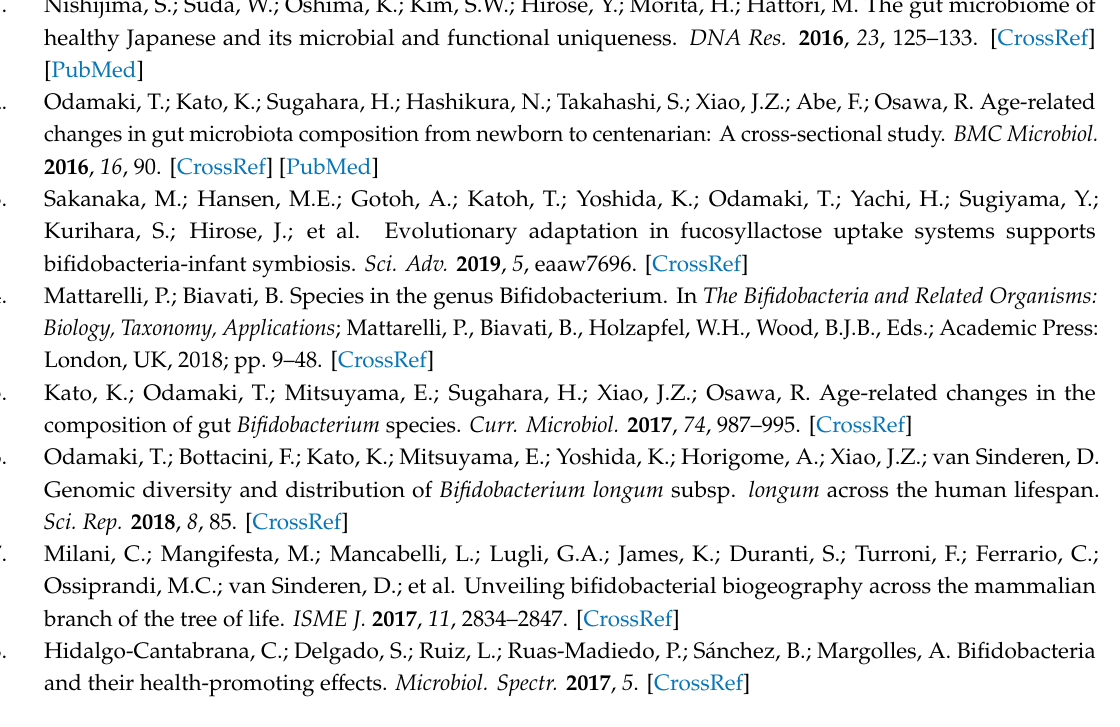
Figure S1: The structure and genomic position of the inserted DNA fragment in representative R-IVET clones, Table S1: Diet compositions for the third and fourth R-IVET